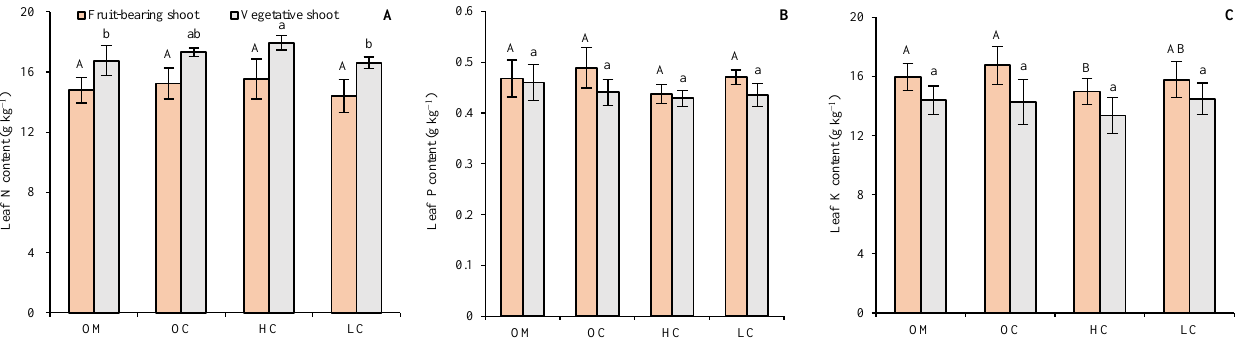
Figure 2. Leaf N ( A ), P ( B ), and K ( C ) contents in fruit-bearing and vegetative shoots of different fertilization modes. Columns represent the mean ( n = 4), and bars represent standard deviation (SD). Different uppercase (lowercase) letters within the fruit-bearing (vegetative) shoot group indicated significant difference (LSD test, p < 0.05). OM, organic fertilization; OC, organic and inorganic fertilization; HC, inorganic fertilization at high rate; LC, inorganic fertilization at low rate.